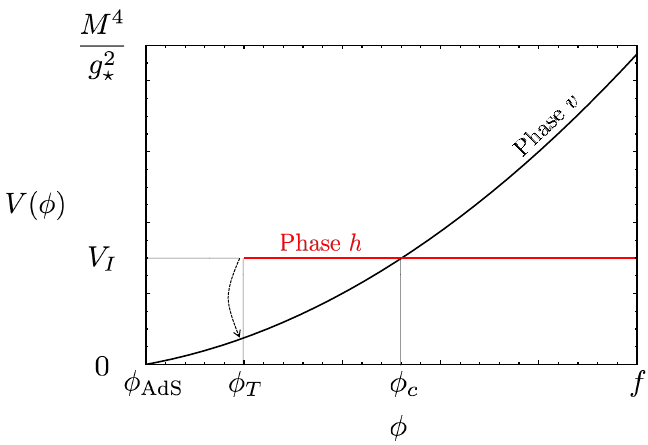
Figure 12 . A sketch of the scalar potential V ( φ ) with the two branches corresponding to phase h (with the microscopic theory residing in the ‘hidden’ vacuum) and phase v (the ‘visible’ vacuum occupied by our Universe). The two branches are degenerate in energy at φ = φ are only allowed at φ = φ , where vacuum h decays into v T